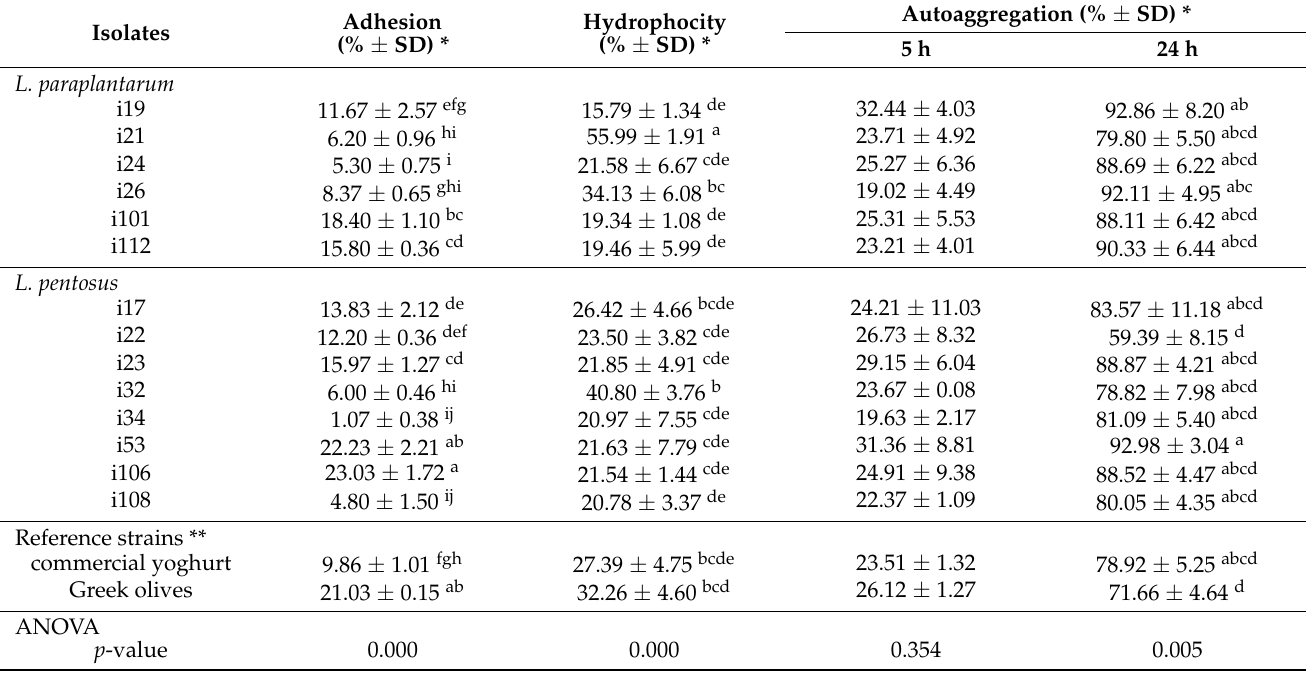
Table 2. Performance of L. pentosus and L. paraplantarum strains pertaining to Caco-cell adhesion, hydrophobicity, and autoaggregation.